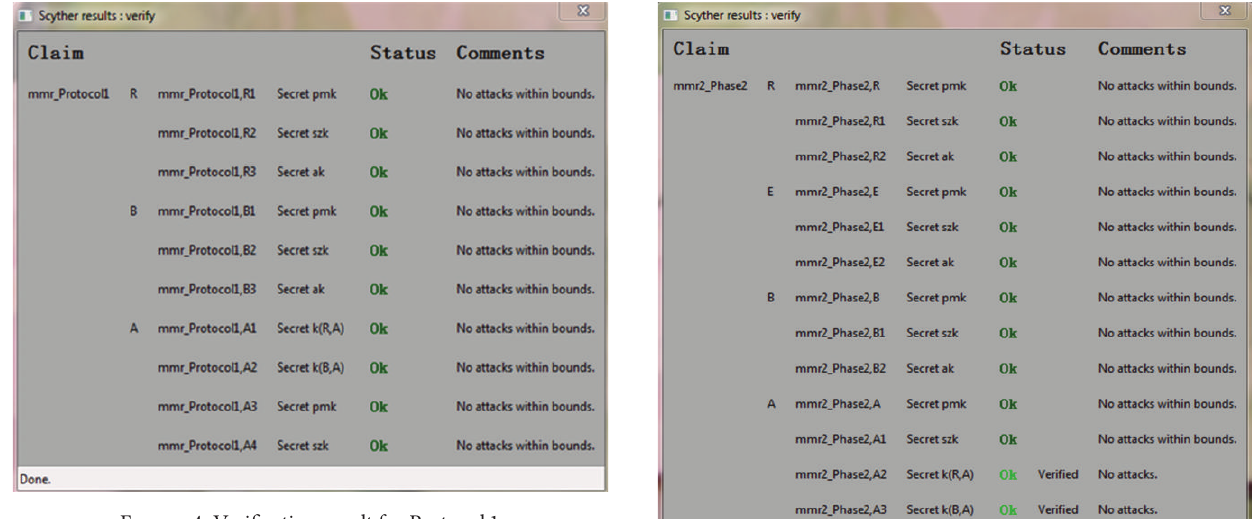
Figure 4: Verification result for Protocol 1.